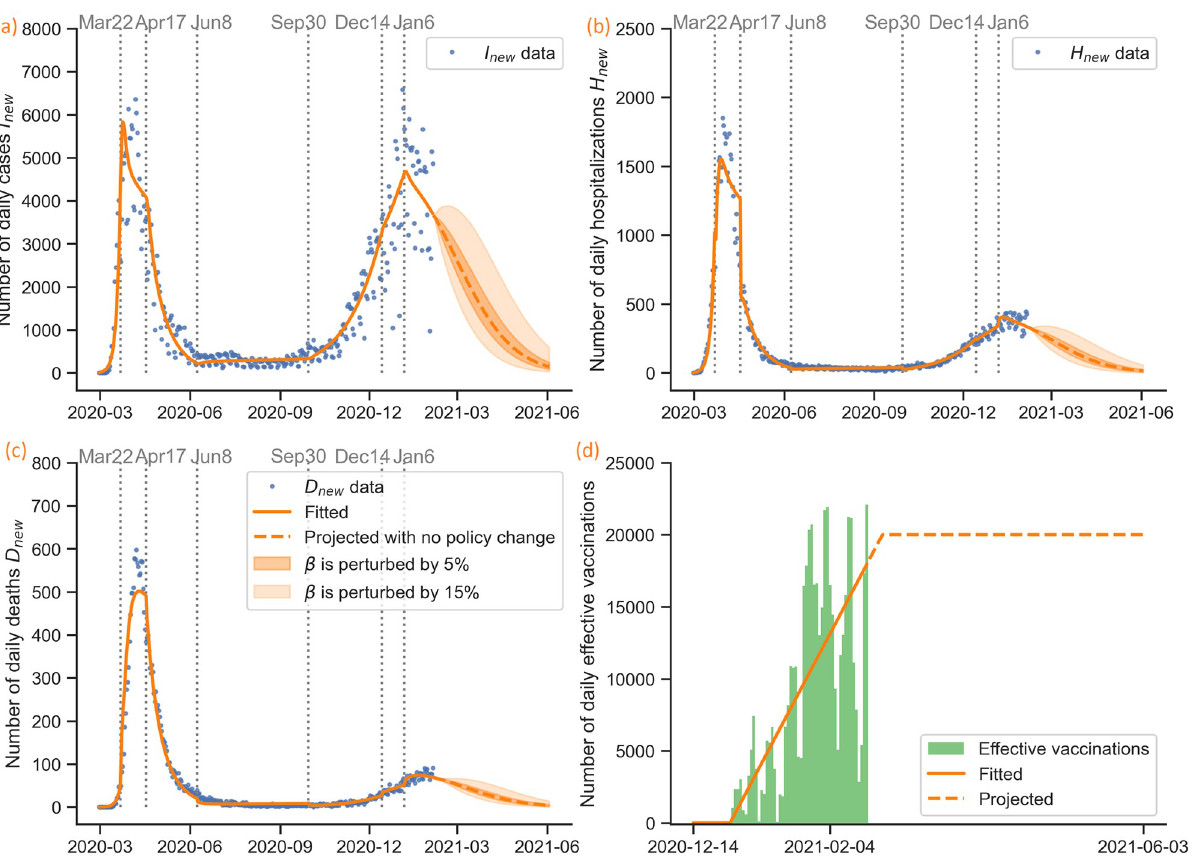
Fig 6. Estimation of daily cases, hospitalizations, deaths, and vaccinations in New York City. (a) Estimation of daily cases. (b) Estimation of daily hospitalizations. (c) Estimation of daily deaths. (d) We calculate the number of effective vaccinations as a weighted sum of the number of first and second doses administered as shown in Fig 2; we approximate the daily number of effective vaccinations linearly and assume it grows linearly until it reaches the maximum capacity of 20,000 per day.